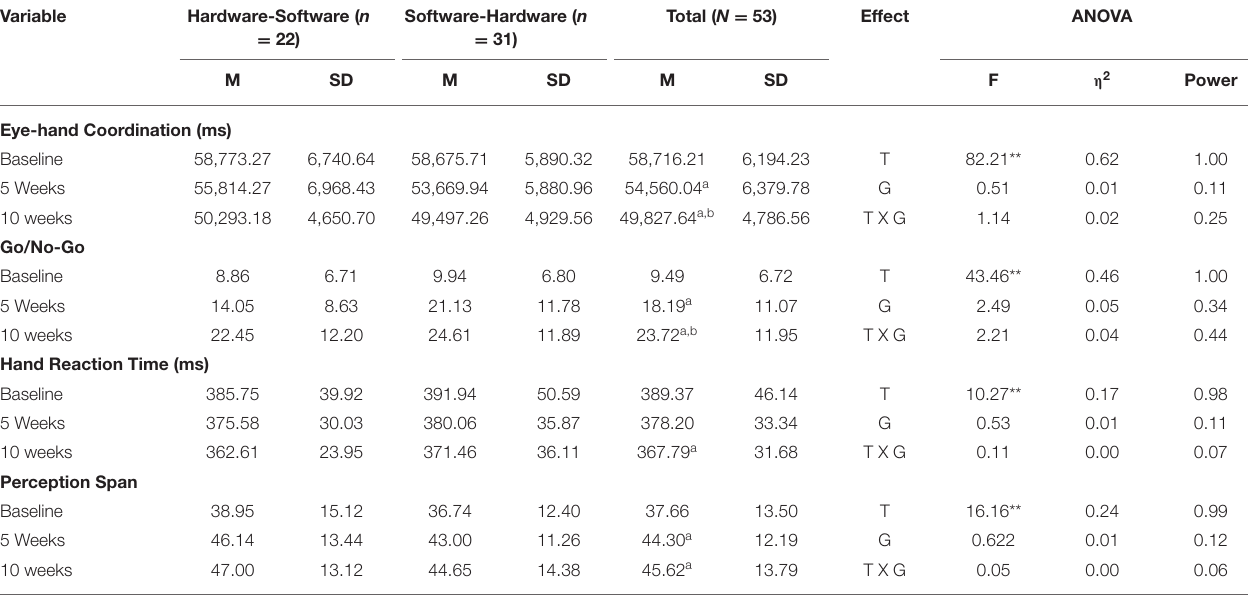
TABLE 4 | Means, Standard Deviations, and Two-way ANOVA statistics for Visuo-Motor Variables.